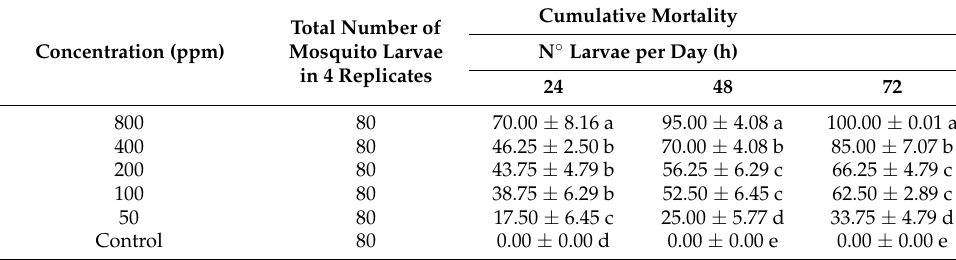
Table 2. Cumulative mortality records of second instar larvae of Aedes aegypti mosquitoes treated with Piper cordoncillo essential oil for three consecutive days.